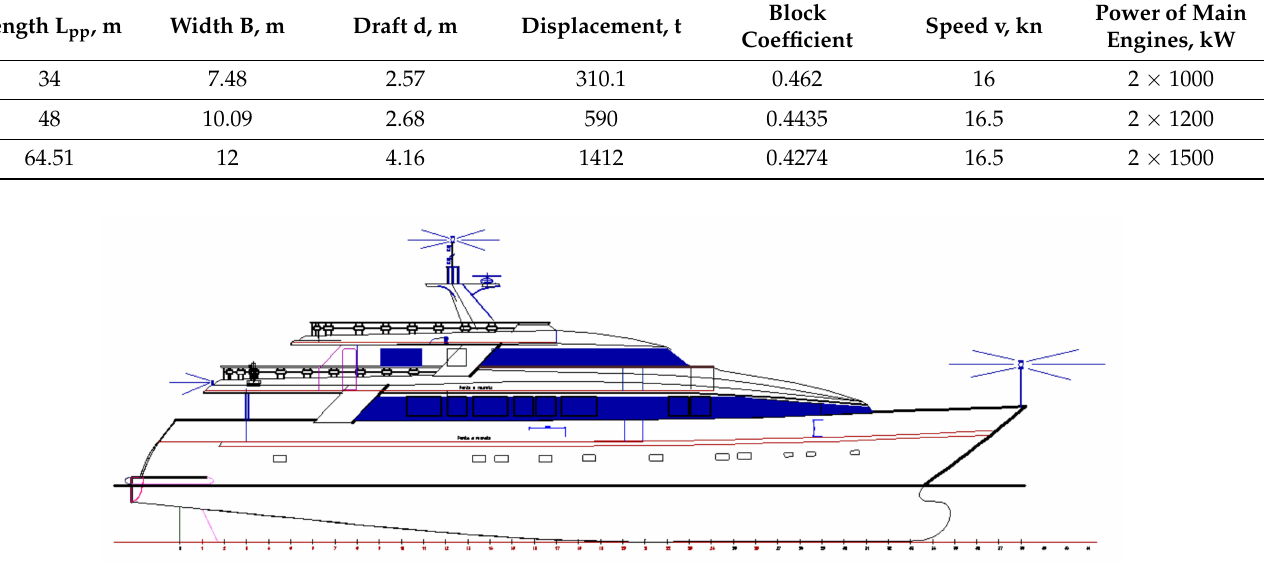
Figure 2. Part of the general arrangement of a yacht (length 34